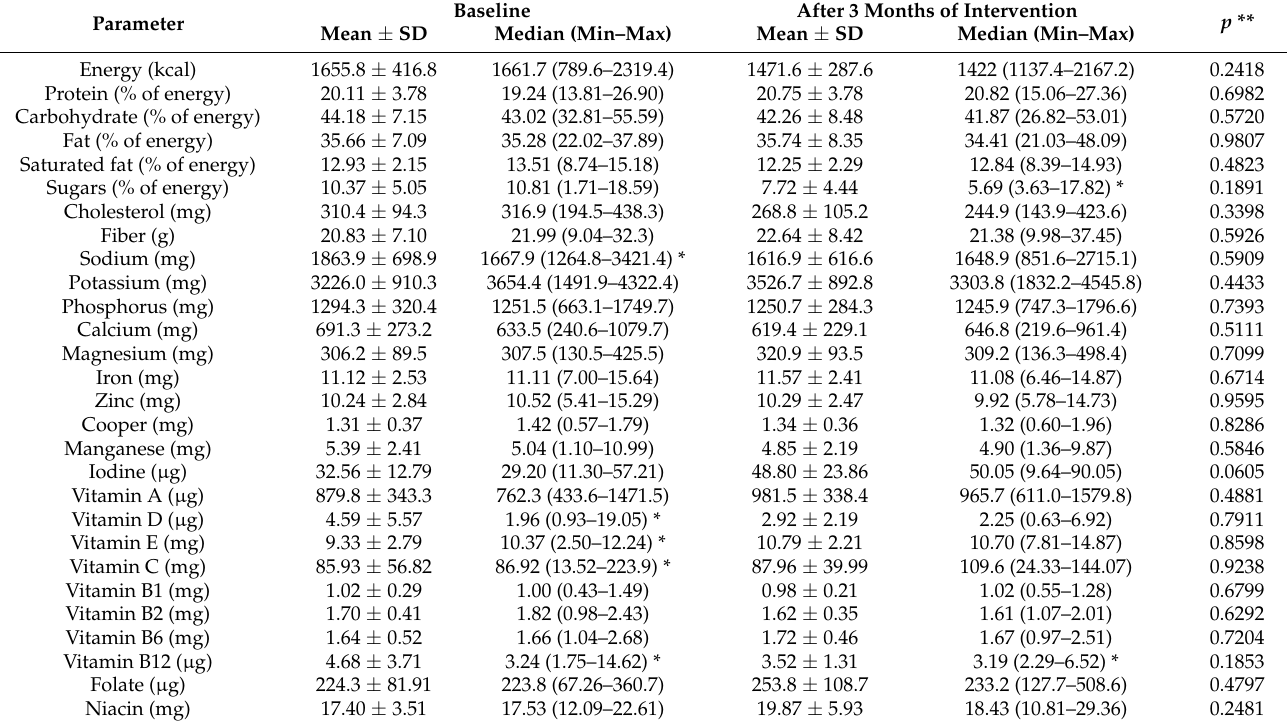
Table 4. The energy and nutritional value of the diet of the female participants at baseline and after 3 months of intervention. Parameter